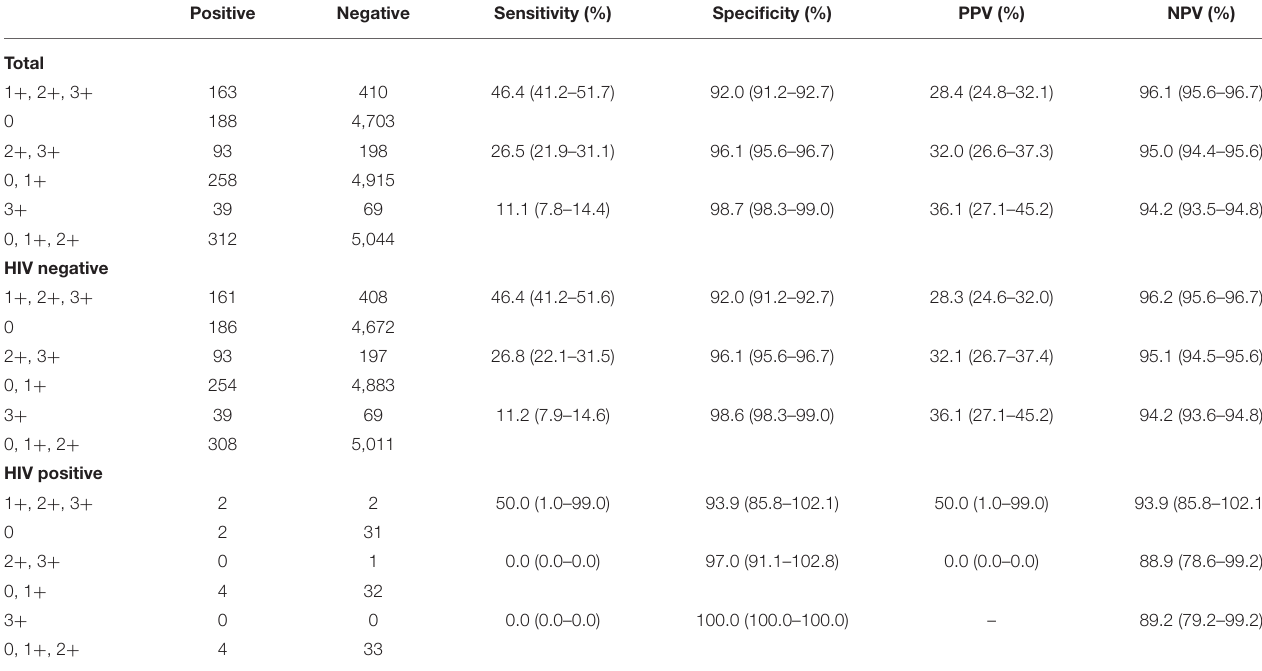
TABLE 3 | Diagnostic performance of LET to predict Chlamydia